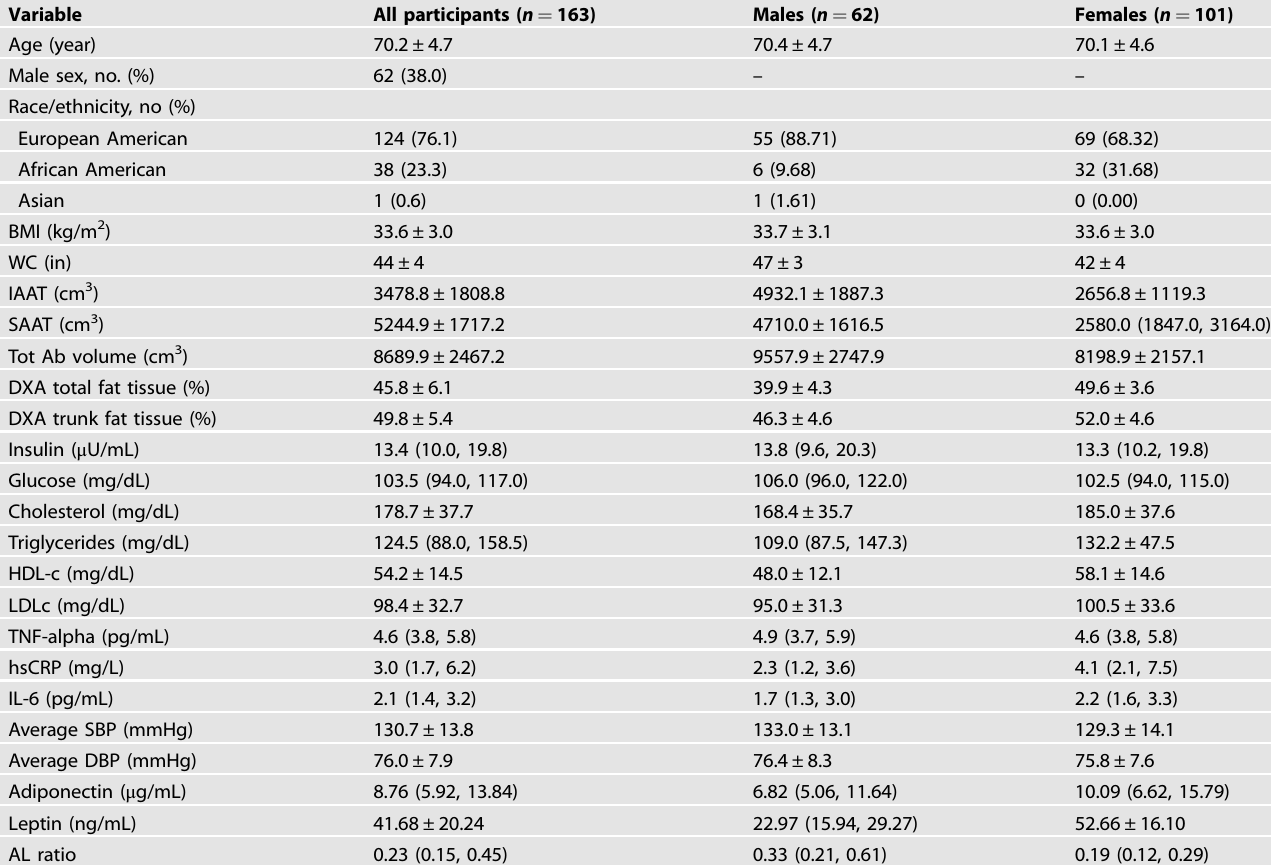
Table 1. Clinical and biochemical baseline characteristics among older adults with obesity following a 12-month exercise and diet